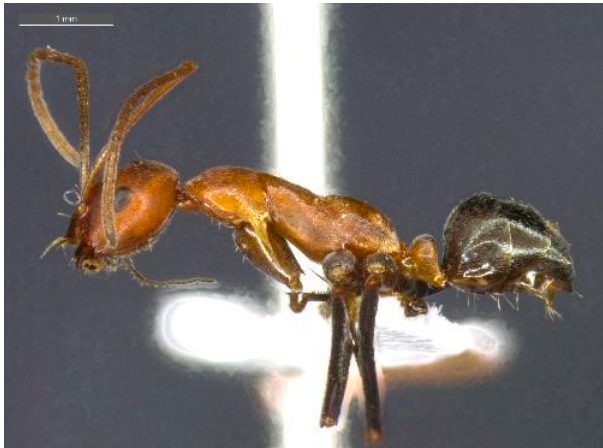
Figure 10. Morphology of Taxon 35C from the sp. 35 complex. Minor worker (BOLD ID: MELPS118-18), known only from the Gove Peninsula.